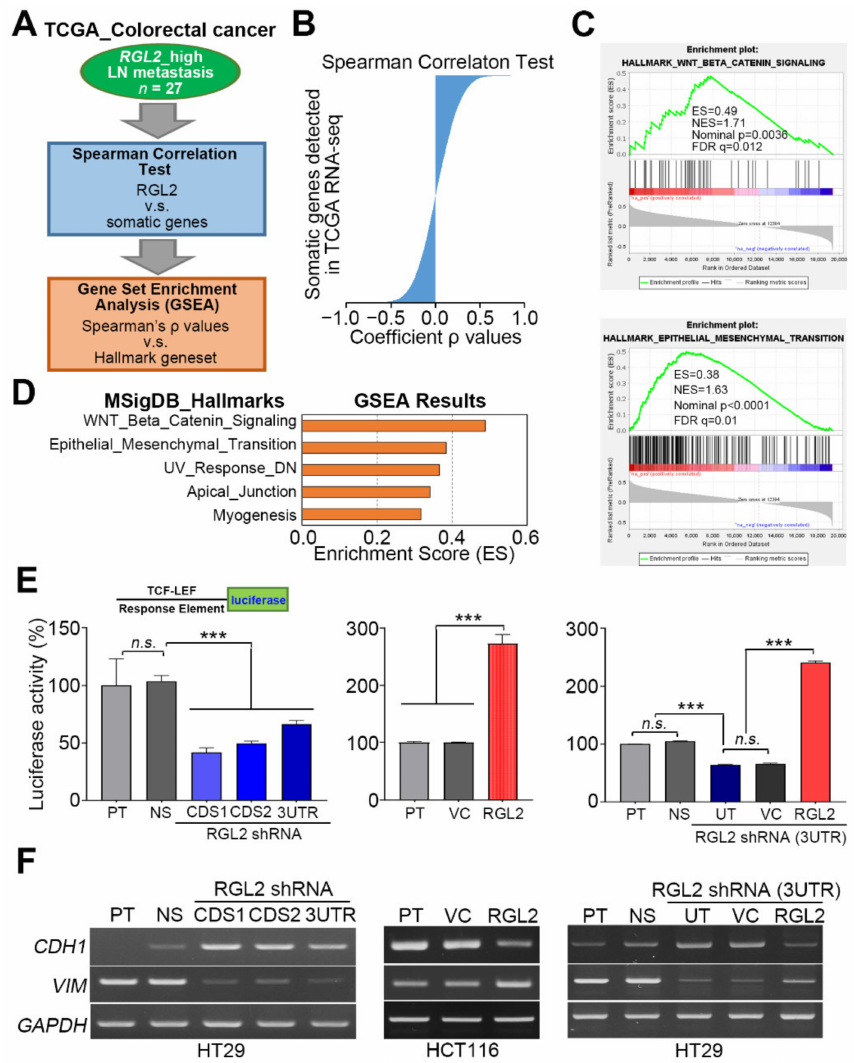
Figure 5. RGL2 upregulation correlates with the activation of the Wnt/ β -catenin signaling axis and EMT progression in CRC. ( A ) The flowchart of generating the RGL2 signature and performing GSEA simulation. ( B ) Spearman’s coefficient ρ -values obtained from RGL2 coexpression with other somatic genes detected by RNA-sequencing experiments in the enrolled TCGA CRC samples. ( C ) The enrichment score (ES) derived from the correlation among the Wnt/ β -catenin and EMT gene sets and the queried Spearman’s correlation coefficient ρ is plotted (green curve). NES and FDR denote the normalized enrichment score and the false discovery rate, respectively. ( D ) Histogram for the enrichment scores of GSEA simulation against the RGL2 signature and hallmark gene sets. ( E ) Histogram for the luciferase activity, relative to parental cells, measured in the HT-29 (left and right) and HCT116 (middle) cell variants transfected with luciferase reporter vector harboring a TCF-LEF response element for 24 h. The “n.s.” and “***” represent not significant and p < 0.001, respectively. ( F ) RT-PCR experiments for the CDH1 and VIM mRNA levels in the indicated HT-29 (left and right) and HCT116 (middle) cell variants. GAPDH was used as an internal control of